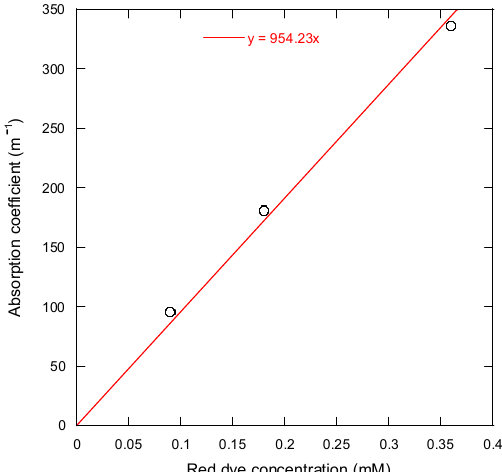
Figure 2. The absorption coefficient with respect to the red dye concentrations in the process (Ag–EG) solution.